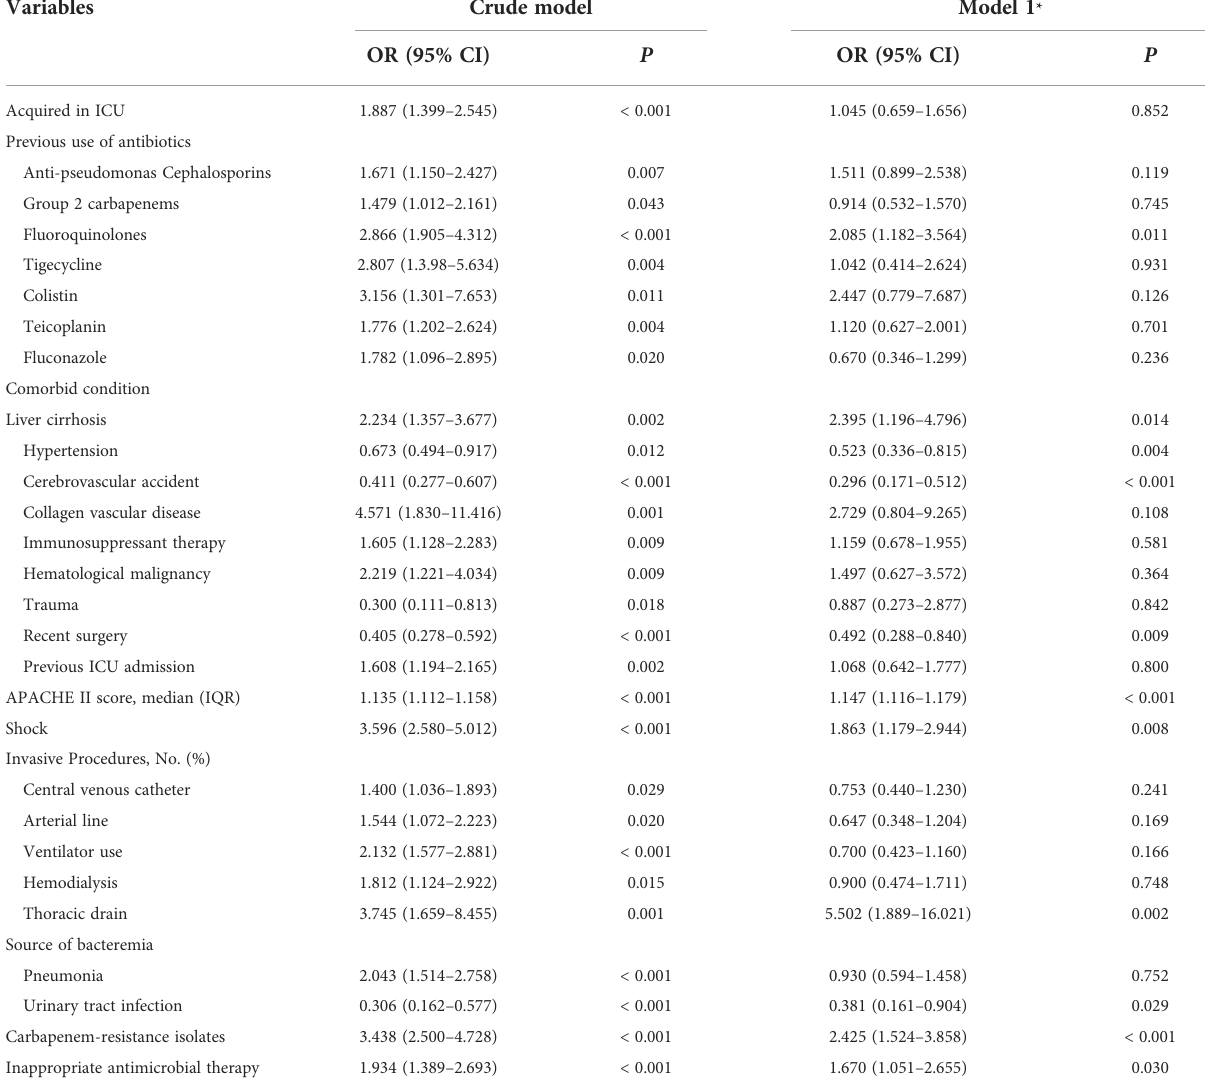
Table 2 Logistic regression analysis for the risk of 28-day mortality in patients with Acinetobacter baumannii bloodstream